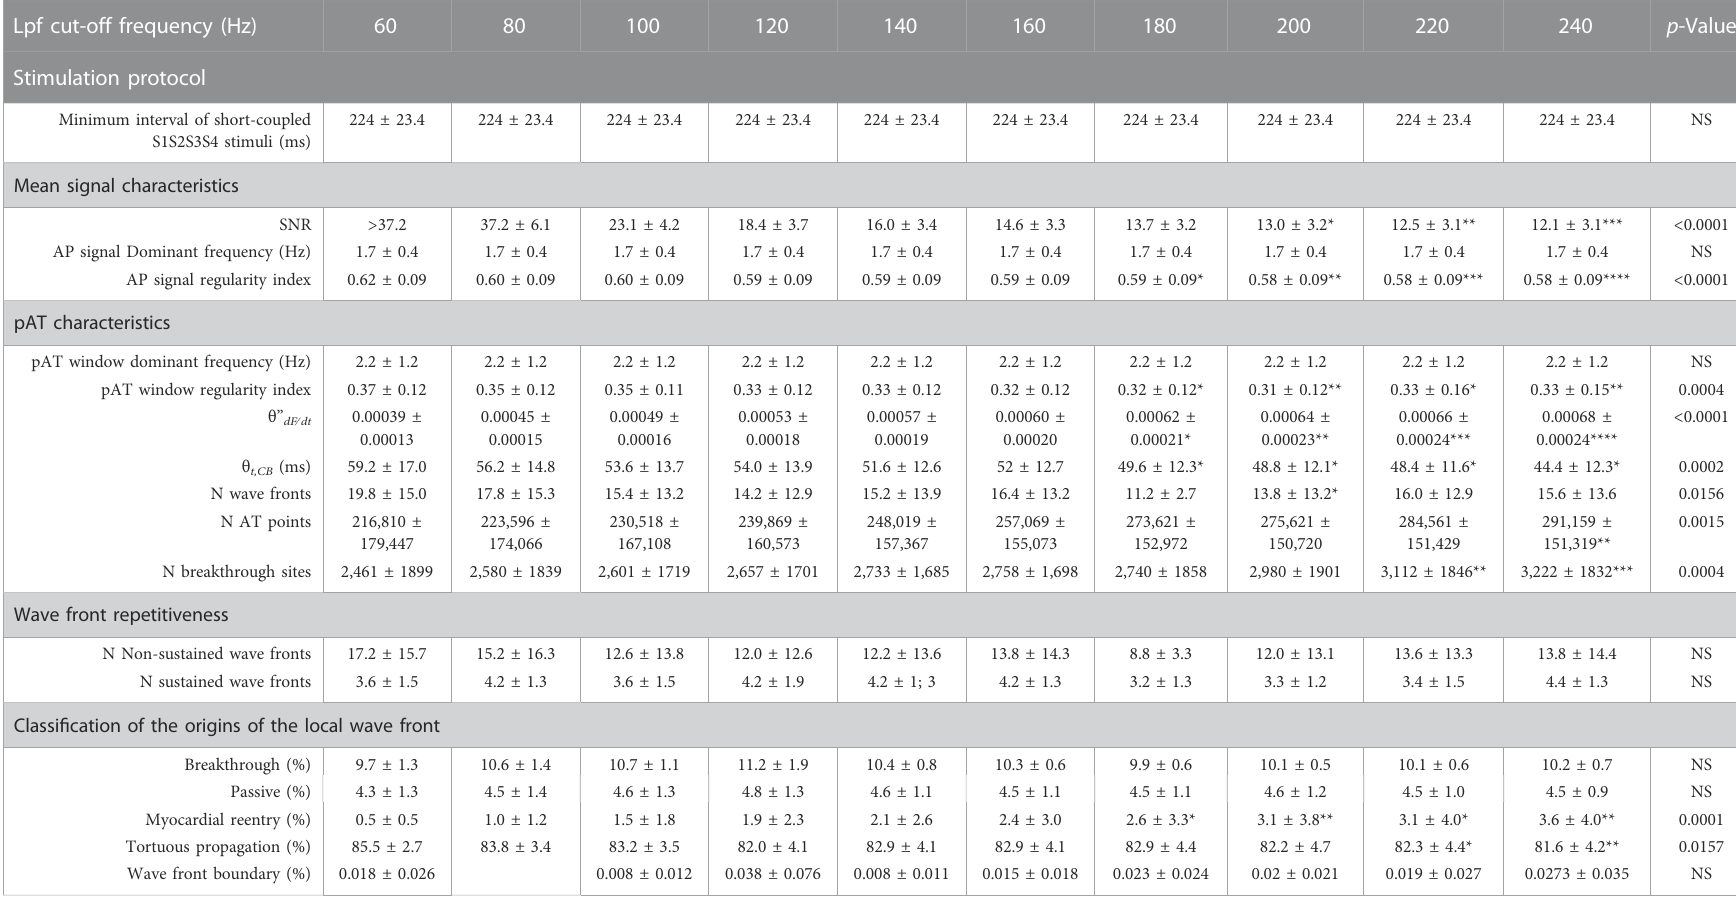
TABLE 1 Repeated use and robustness of the novel pAT mapping framework in experimental cases. Ventricular arrhythmia was induced in fi ve experiments using an S1S2S34 induction protocol. Lpf cut-off frequency